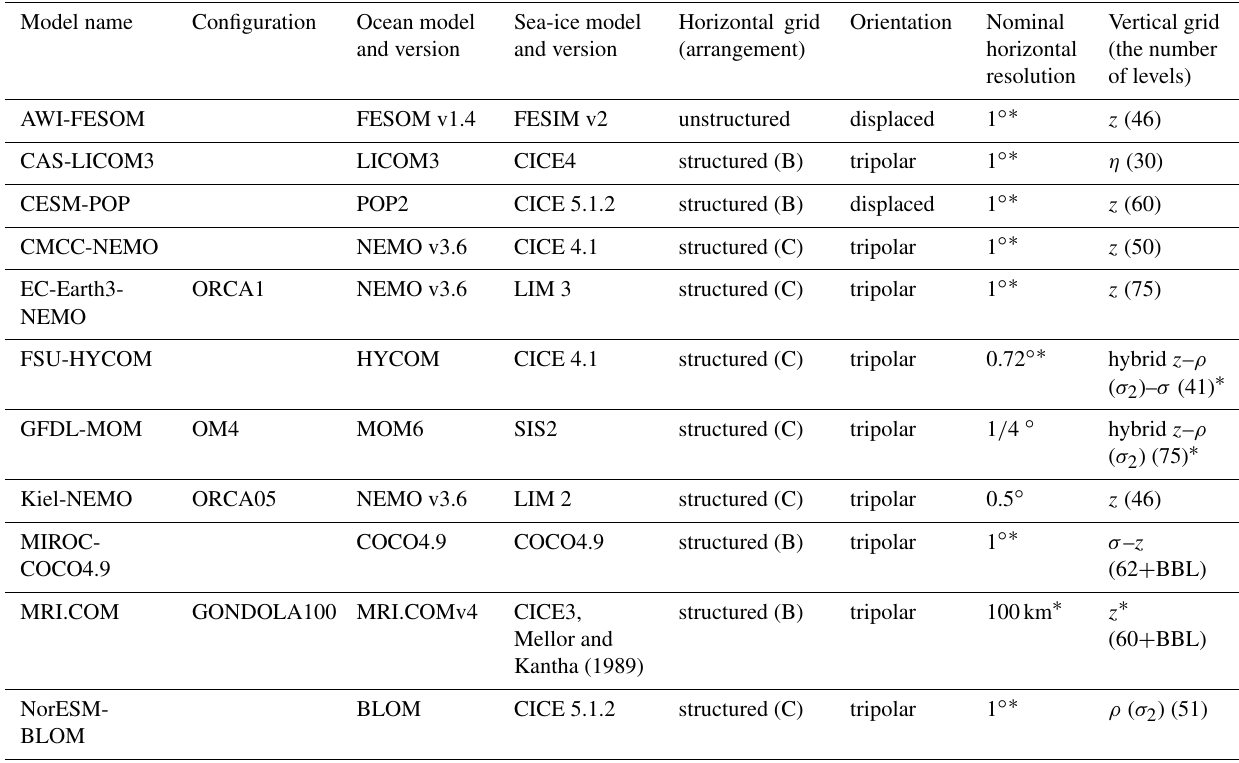
Table 1. Configurations of participating models. See Appendix A for detailed